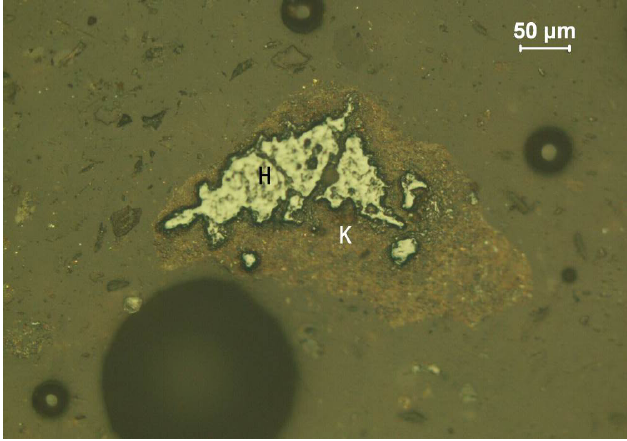
Figure 3. Granular hematite (H) filled in the particles of kaolinite (K) under reflected light. CaCO 3 of analytical grade was used to adjust the binary basicity of blends. The soft coal was used as a reductant agent, with fixed carbon of 52.12% on an air dry basis